Question: How would you classify this visualization?
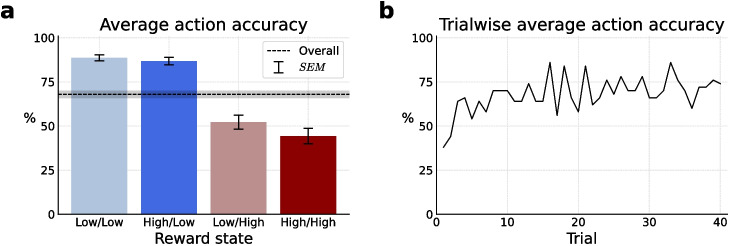
Answer: bar